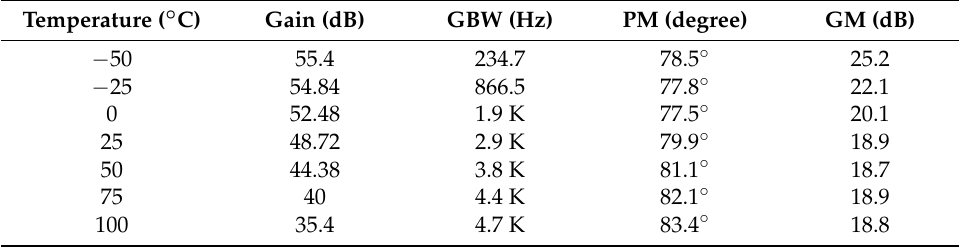
Table 3. Effect of temperature variation on the ac response.